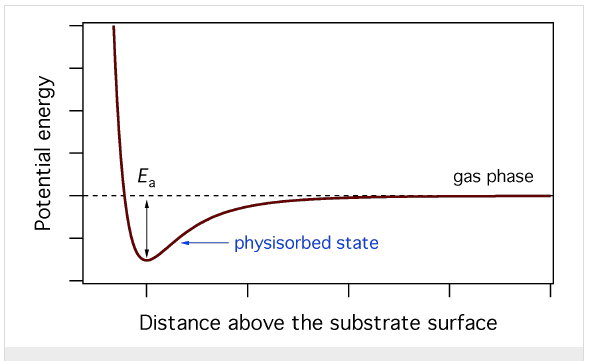
Figure 2: Potential energy diagram for adsorption governed by a single potential well at the surface. Modified from [18].